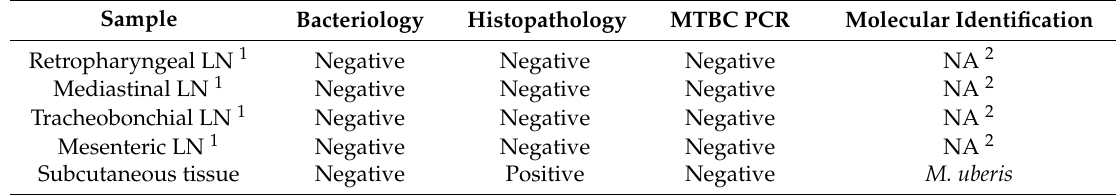
Table 1. Summary of bovine tuberculosis (bTB) surveillance tests